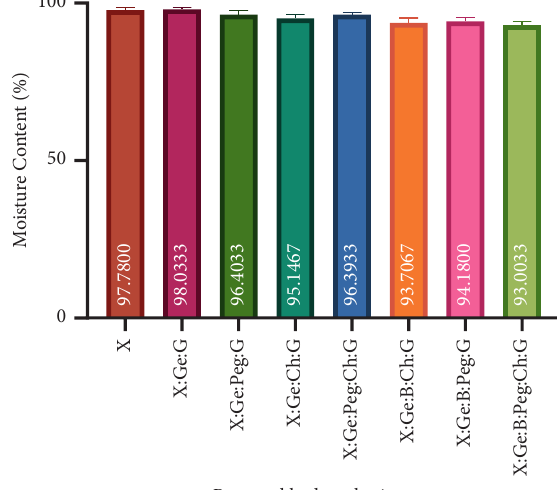
Figure 2: Moisture content of prepared hydrogel mixtures. All hydrogels had a water content of more than 93%. This strongly shows that hydrogels are effective at donating water to wound sites and that the water content of hydrogels helps wound healing by keeping the environment wet. Results are expressed as mean ±